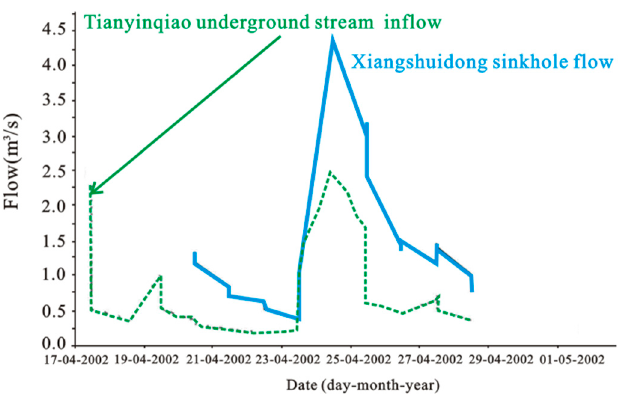
Figure 9. Fluctuation graph of flow rate at the inlet and outlet of the Deshengchang subterranean stream. Image reproduced from [25].